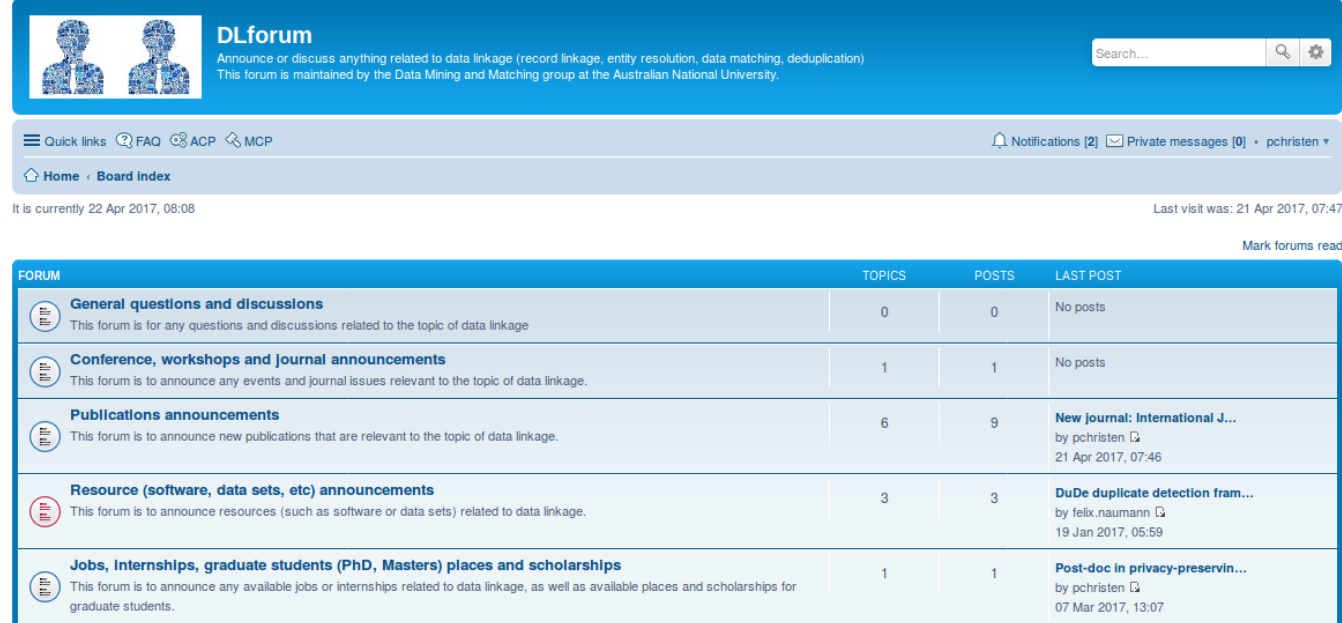
Figure 1: Main page of the DLforum showing the five main forum